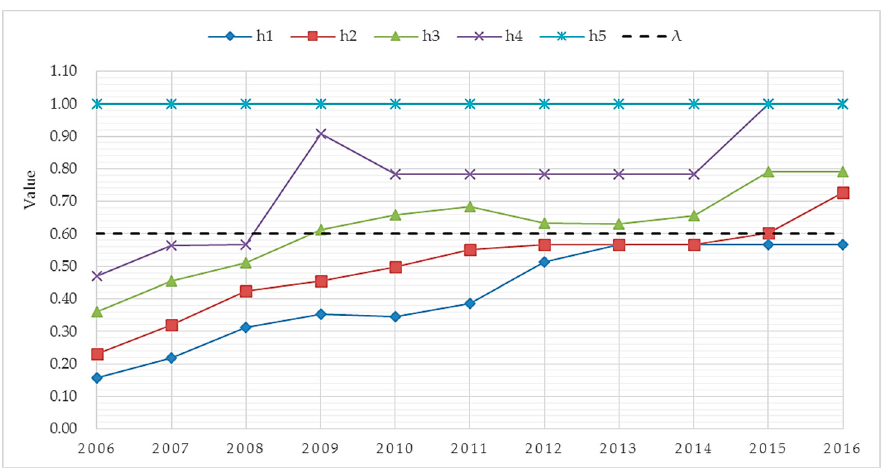
Figure 9. Cumulative connection degree trends for the response subsystem from 2006 to 2016.